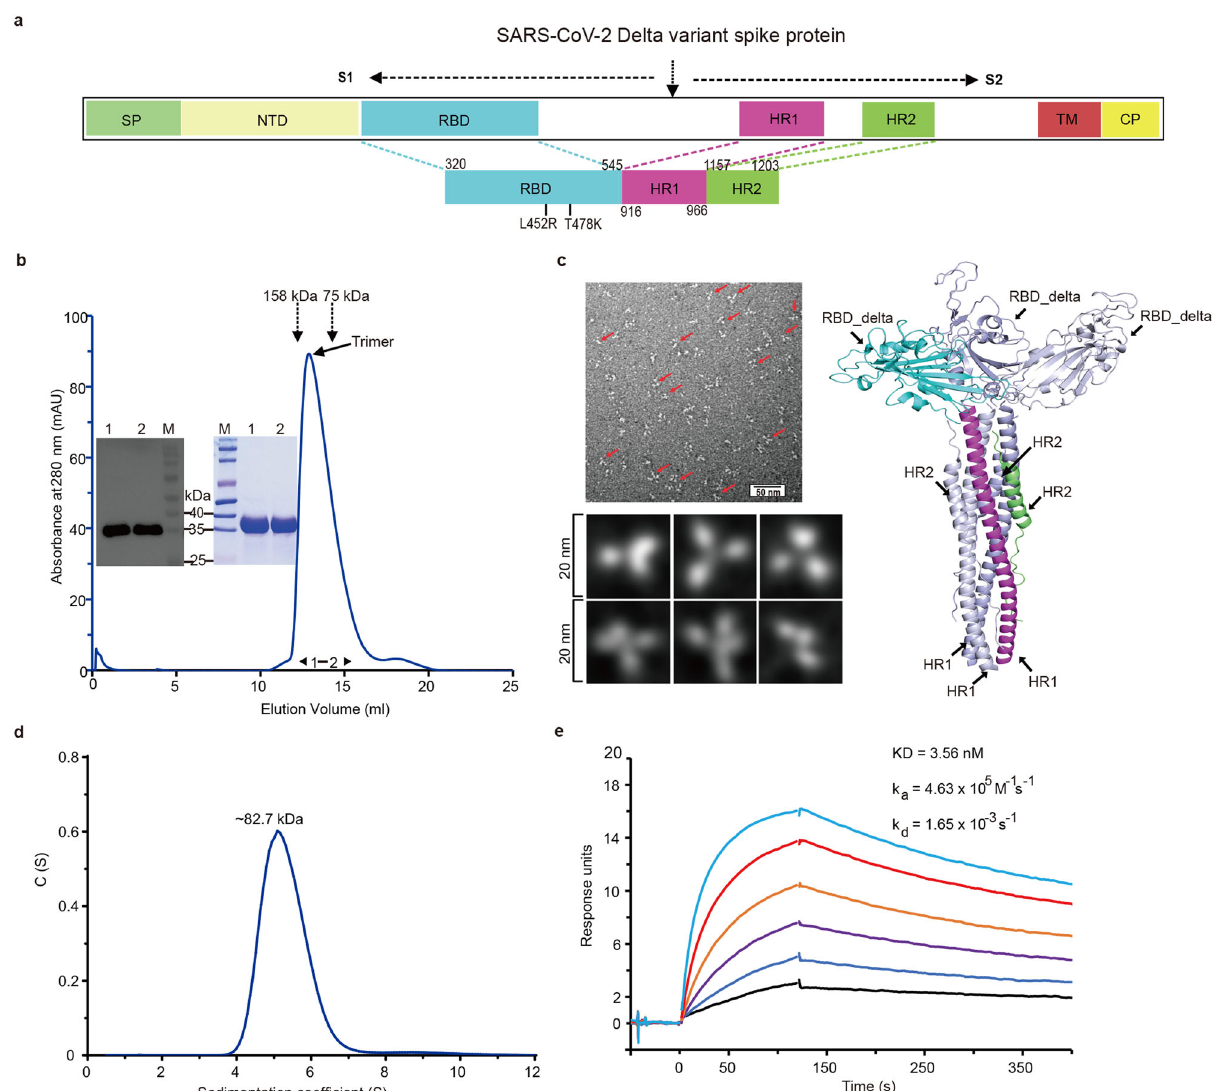
Fig. 1 | Characterization of the recombinant RBD-HR/trimer protein. a The schematicrepresentationof the SARS-CoV-2Delta variant spike protein. Our RBD- HR/trimer protein includes a RBD (320 – 545 aa) derived from the Delta variant (containing L452R and T478K mutations) and HR1 (916 – 966 aa) and HR2 (1157 – 1203 aa) domain in subunit S2 of spike protein. SP signal peptide, NTD N-terminal domain, RBD receptor binding domain. HR1 and HR2 heptad repeats 1 and 2, TM transmembrane domain, CP cytoplasmic domain. b A representative elution chromatograph of the recombinant RBD-HR/trimer protein using a cali- brated Superdex Increase 200 column. The SDS-PAGE and Western blotting ana- lyses of the eluted RBD-HR/trimer protein were shown. mAU milli-absorbance